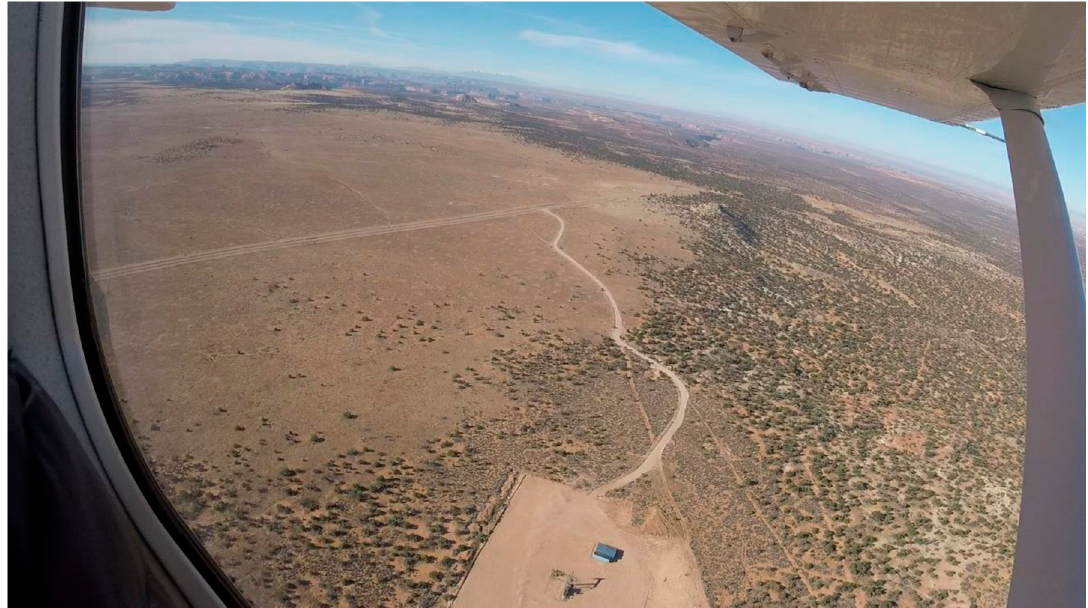
Figure 6. Oil rig near Canyonlands. Just north of park boundaries, and on some of the approach roads, oil rigs can be observed. Photograph by Tatyana Martello, November